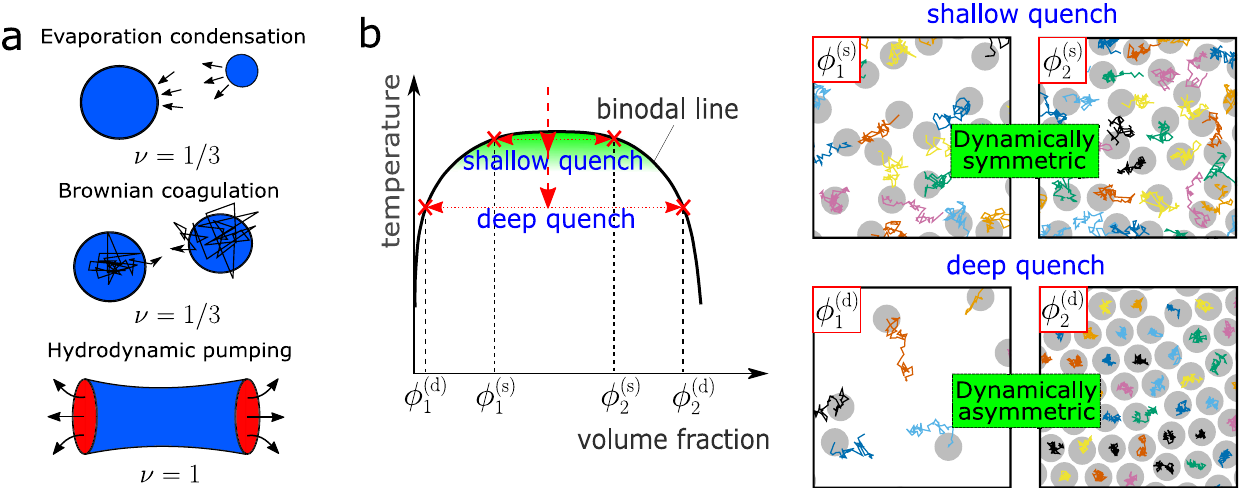
Fig. 1 Phase separation and dynamic asymmetry. a Three classical coarsening mechanisms for phase separation and the corresponding growth exponents ν . b The left panel shows a typical phase diagram of colloidal suspensions. For a shallow quench, the two phases have similar relaxation time τ α because of the similar colloid volume fraction, ϕ , between the two phases (see the upper right panel ‘ shallow quench ’ , where we can see similar particle mobilities between the two phases; each particle trajectory is coloured differently). Since the domain deformation rate induced by phase separation is much slower than 1/ τ α , both phases behave as viscous liquids. In this case, the growth exponents are those known for classical coarsening mechanisms 17,18,20 . Such behaviours are observed only for a very shallow quench condition (see the green-shaded region; see also Fig. 2). For a deeper quench, on the other hand, the phase with higher ϕ has a much slower relaxation time than the one with lower ϕ (see the lower right panel ‘ deep quench ’ , where we can see very different particle trajectories between the two phases), and the phase separation proceeds with an average speed between them. As a result, the higher ϕ (slower) phase cannot catch up with the domain deformation speed and thus behaves as an elastic body transiently. Thus, the viscoelastic response of the higher ϕ phase plays a dominant role in the domain coarsening dynamics, which cannot be described in the conventional theory of phase separation of fl uid mixtures. Here we emphasise that this effect is essential in a broad region of the phase diagram in various dynamically asymmetric systems (see Fig.